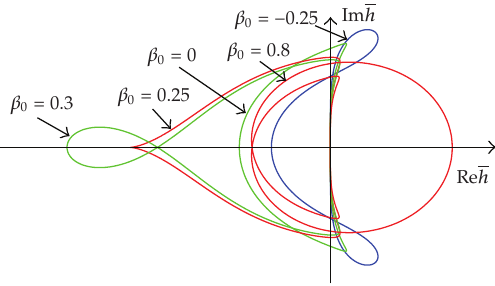
Figure 2: Regions of absolute stability for LMMs (cid:3) 4.3 (cid:4) with a (cid:5) b (cid:5) c (cid:5) 0.